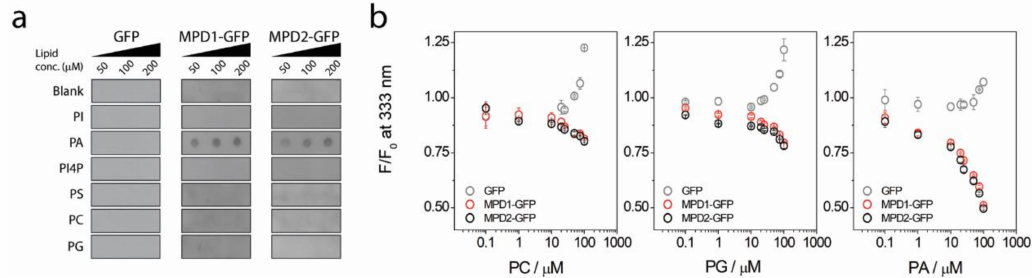
Figure 2. Interaction of MPD domain from TRPV1 and TRPV2 with phosphatidic acid (PA). ( a ) Blank (only buffer), PI, PA, PI4P, PS, PC, or PG lipids were immobilized on nitrocellulose membranes at concentrations (conc.) of 50, 100, or 200 µ M. Purified recombinant GFP or MPD-GFP from TRPV1 or TRPV2 channels were incubated on the lipid-containing nitrocellulose membranes and detected using an anti-GFP antibody. ( b ) Tryptophan quenching experiments. GFP tryptophan fluorescence (emission at 333 nm) of free GFP or MPDs from TRPV1 or TRPV2 was monitored in the presence of increasing concentrations of the different lipid polar head-groups (Phosphatidylcholine, POPC, 1,2-Dipalmitoyl-sn-glycero-3-phosphate (DPPA), and Phosphatidylglycerol (POPG))